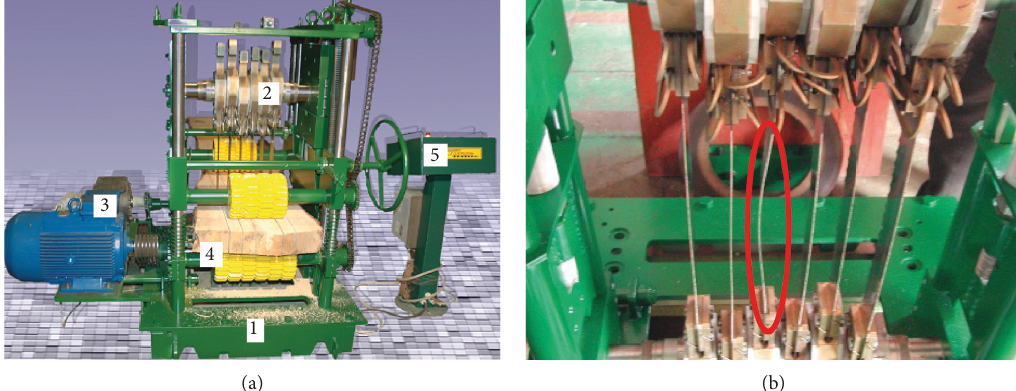
Figure 4: The frame saw machine in the experiment and resonant oscillation of the tooth blade: (a) frame saw machine in the experiment and (b) resonant oscillation causing breakage of a blade structure.